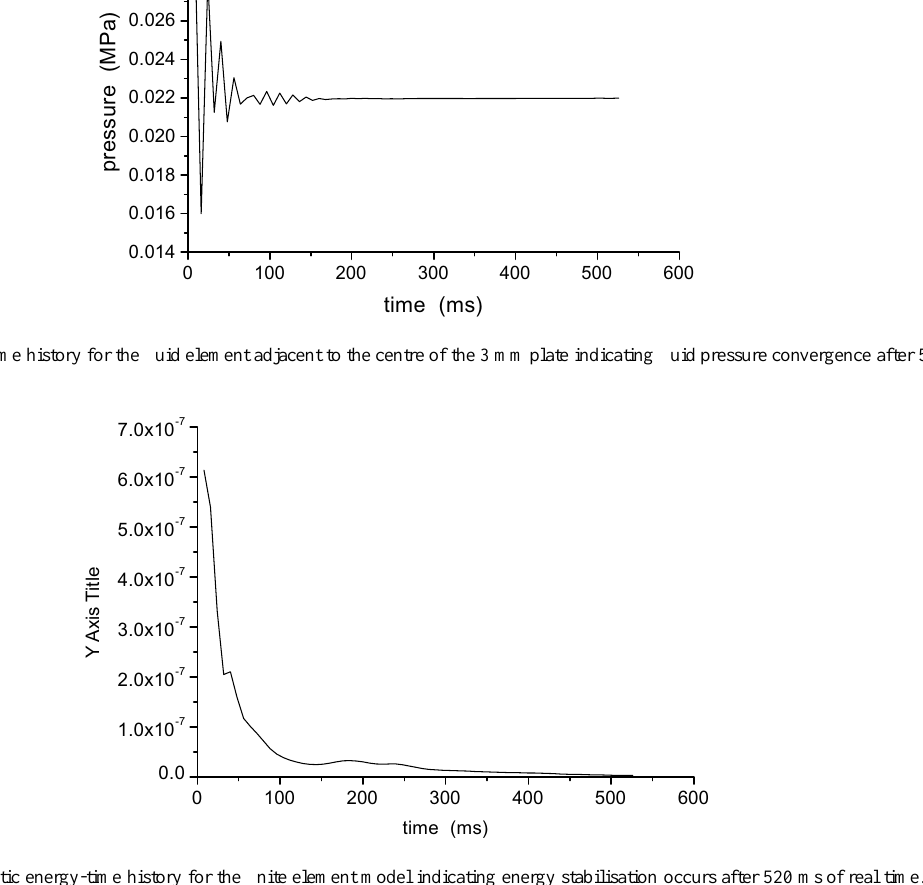
Fig. 5. The kinetic energy-time history for the finite element model indicating energy stabilisation occurs after 520 ms of real